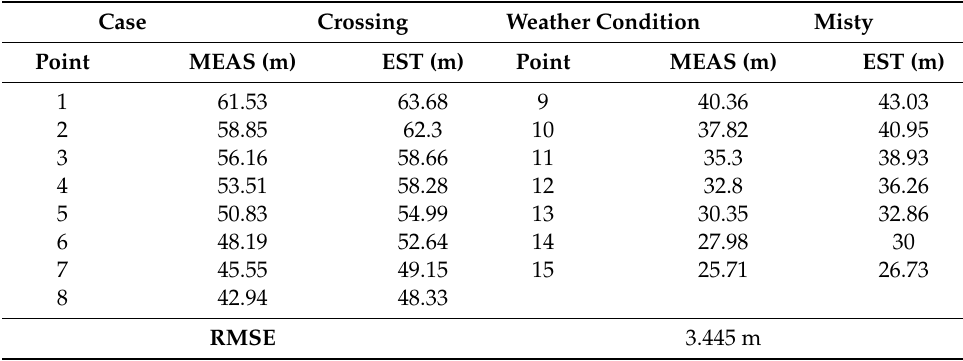
Figure 25. Result of model evaluation in Experiment 2. Table 7. Experiment 2 (estimation vs. GPS measurement).